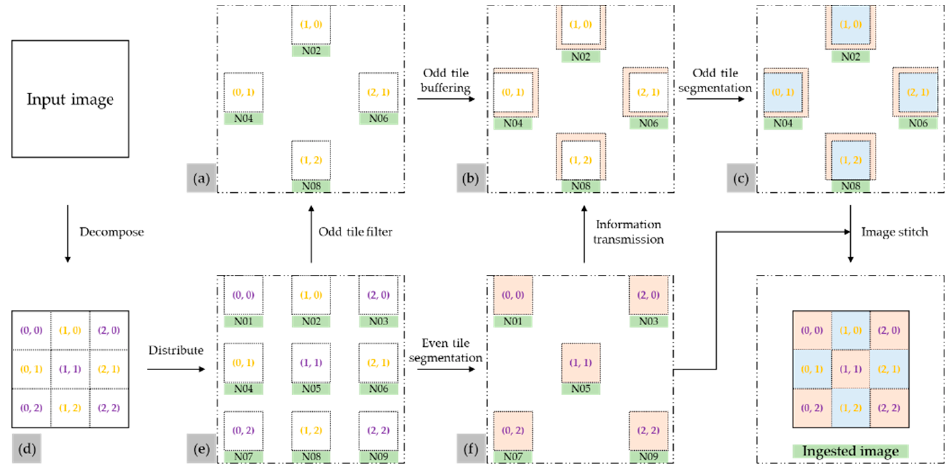
Figure 2. The detailed workflow of the distributed image segmentation strategy. ( a ) Filtered Odd tiles; ( b ) Buffered Odd tiles; ( c ) Segmented Odd tiles; ( d ) Decomposed image; ( e ) Distributed image tiles; ( f ) Segmented Even tiles.